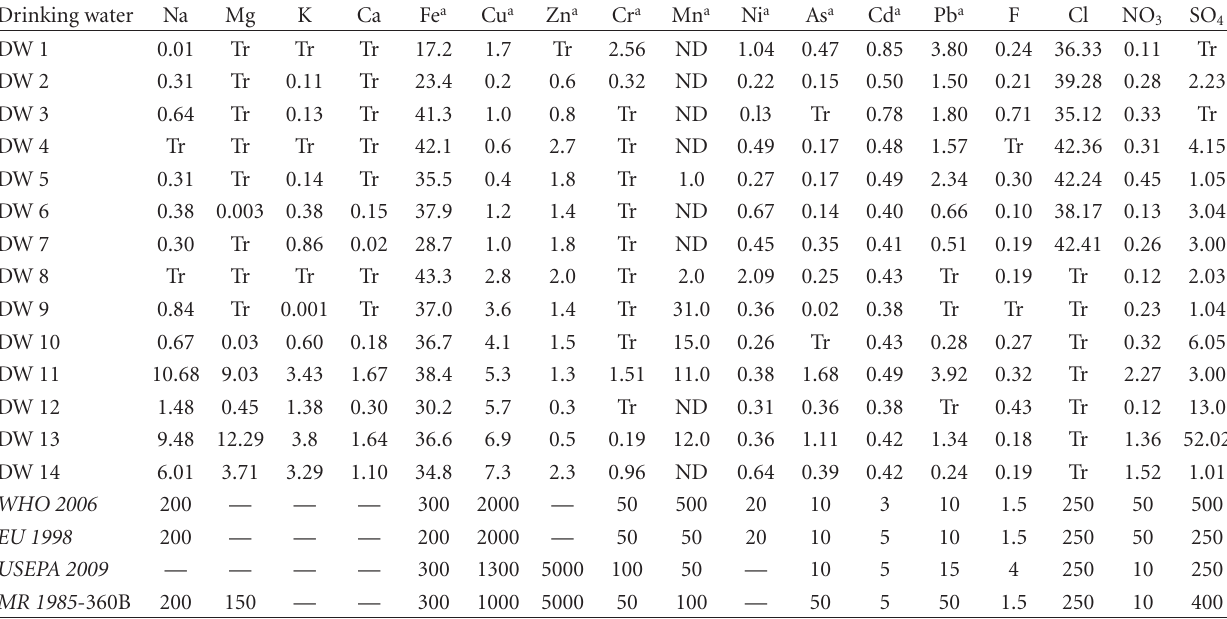
Table 2: Mineral concentrations in drinking water (DW) samples and the standard limits recommended by Malaysian Food Regulations and international